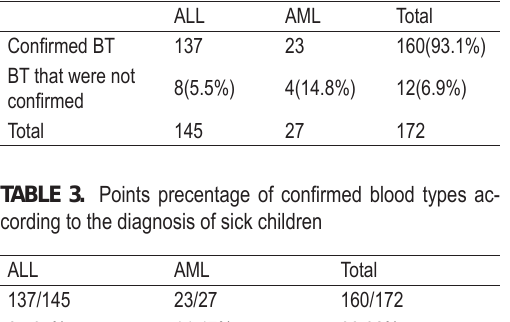
TABLE 2. Con fi rmedBlood types: